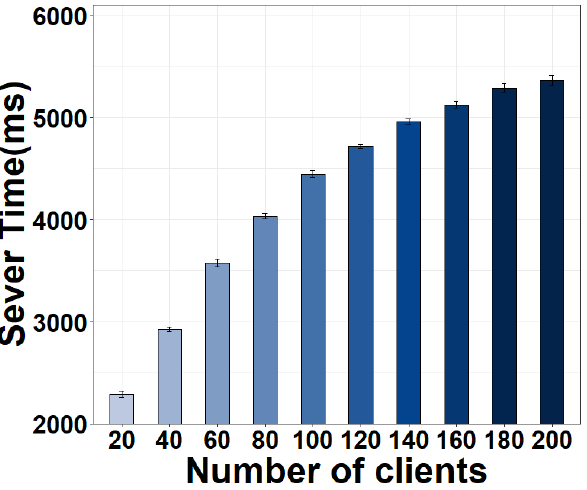
Figure 21. The server time of Zeus increases as the number of clients